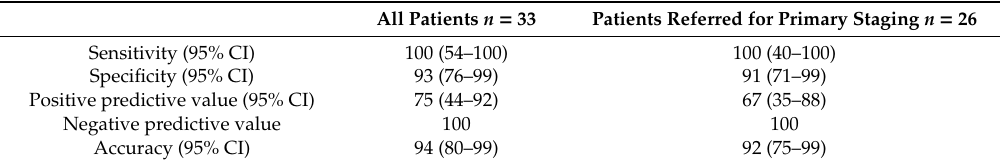
Table 4. Patient-based diagnostic performances of 68 Ga-PSMA PET / CT on patients with the most valid